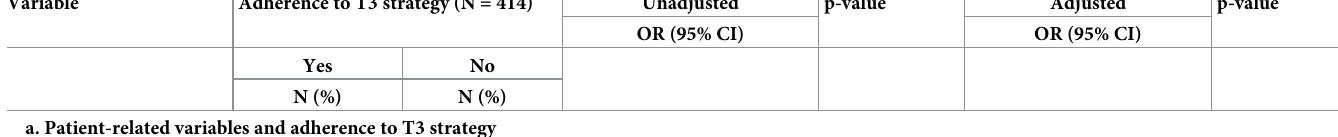
Table 2. Multivariate analysis of association between patient, health facility and prescriber related variables and adherence to T3 strategy, Mfantseman Municipal- ity, 2022. Variable Adherence to T3 strategy (N =